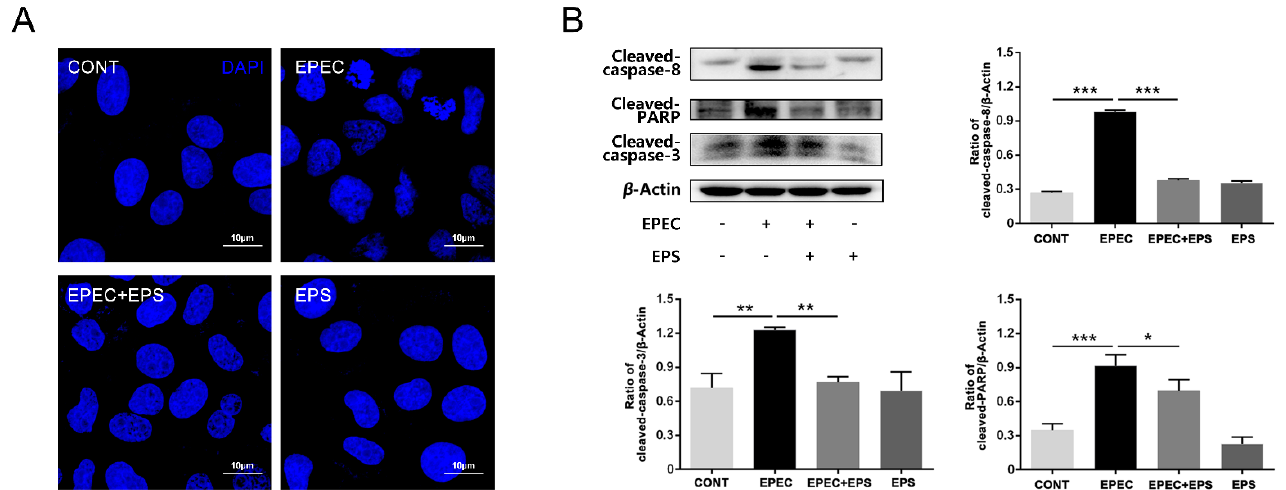
Figure 2. Pretreatment with EPS alleviated EPEC-induced cell apoptosis in IPEC-J2 cells. ( A ) Detection of the apoptotic morphological changes in IPEC-J2 cells by DAPI staining. Scale bars, 10 µm. ( B ) Western blot analysis for the protein levels of cleaved-caspase-8, cleaved-PARP, and cleaved-caspase-3 in IPEC-J2 cells and surrounding panel was the quantitation analysis by Image J software. The data was presented as mean ± SEM ( n = 3), * p < 0.05, ** p < 0.01, *** p <